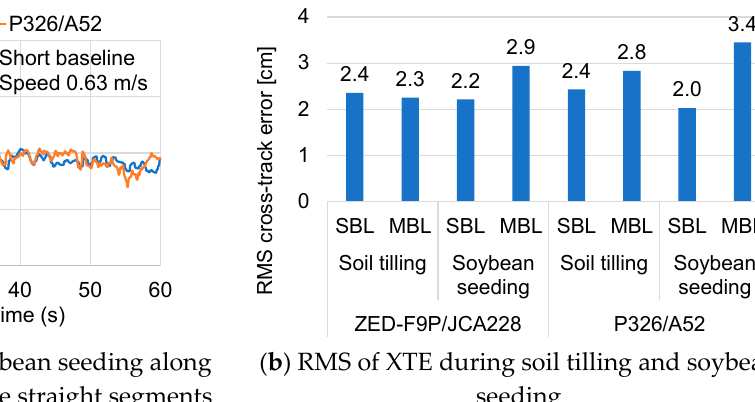
Figure 11. XTE during soybean seeding along the centermost 50 m.